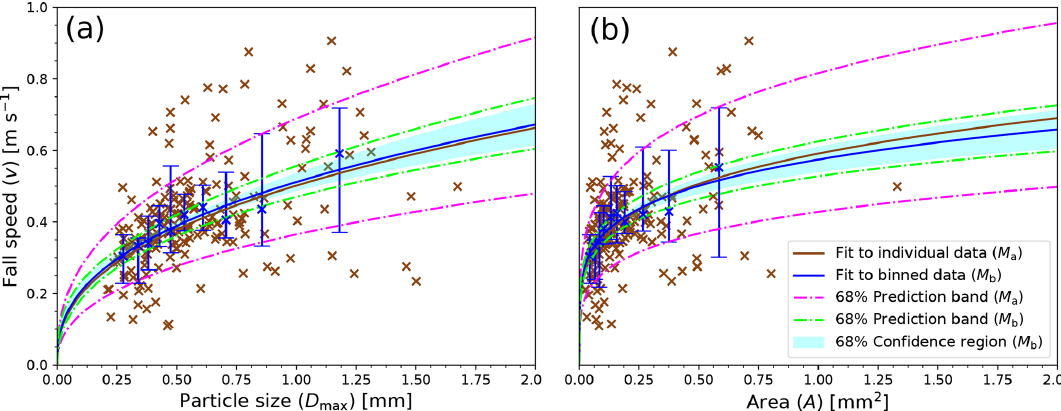
Figure 6. Fall speed vs. particle size ( v vs. D max ) and fall speed vs. cross-sectional area ( v vs. A ) relationships for shape group (5) Plates . Individual data (brown symbols) and binned data (blue symbols with error bars) are displayed. Median values in the respective bins represent the binned data. The total length of the error bars represents the spread in fall speed data, which is given by the difference between the 16th and 84th percentiles. Fits that apply to individual data ( M a ) and to binned data ( M b ) are shown for comparison. The 68% prediction bands for both fits ( M a , M b ) are shown. The 68% confidence region is shown for M b . (a) v vs. D max relationship given by Eq. (4). (b) v vs. A relationship given by Eq. (5). The same data are shown in Table 3 for v vs. D max and in Table 4 for v vs. A